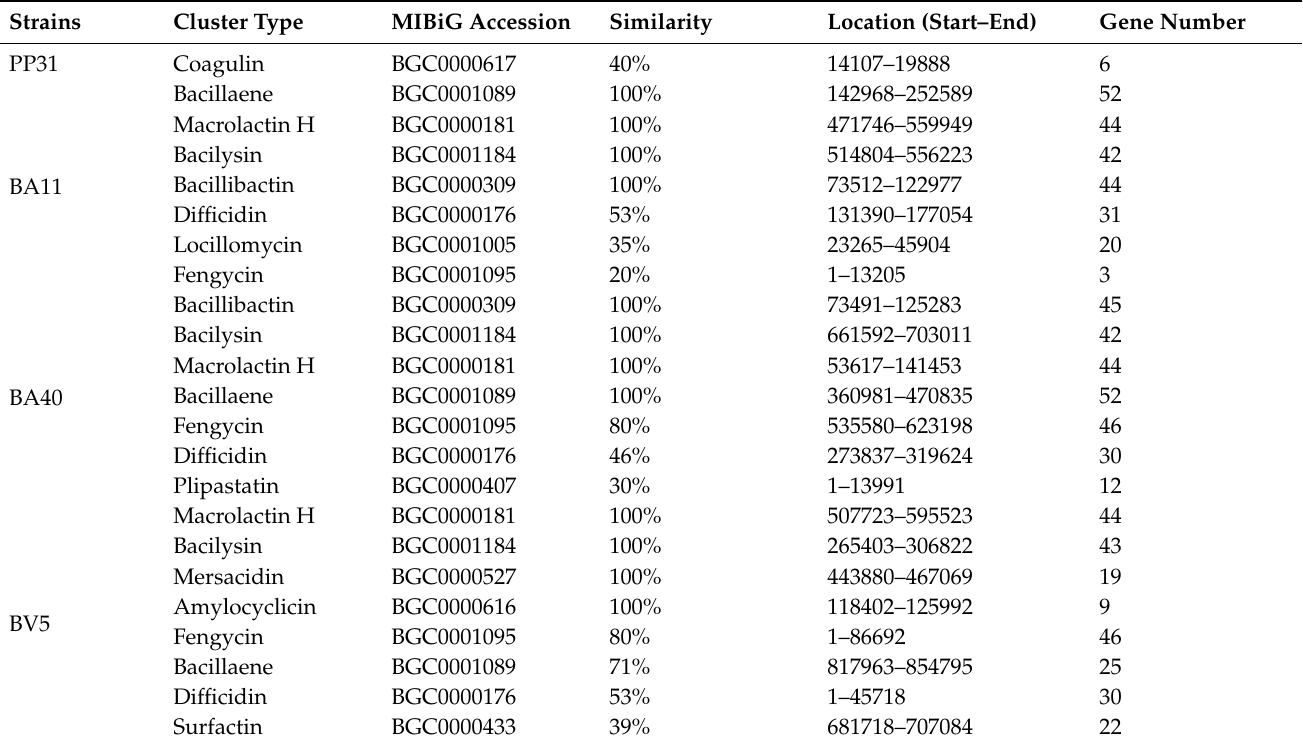
Table 3. Secondary metabolites predicted by the antiSMASH database.